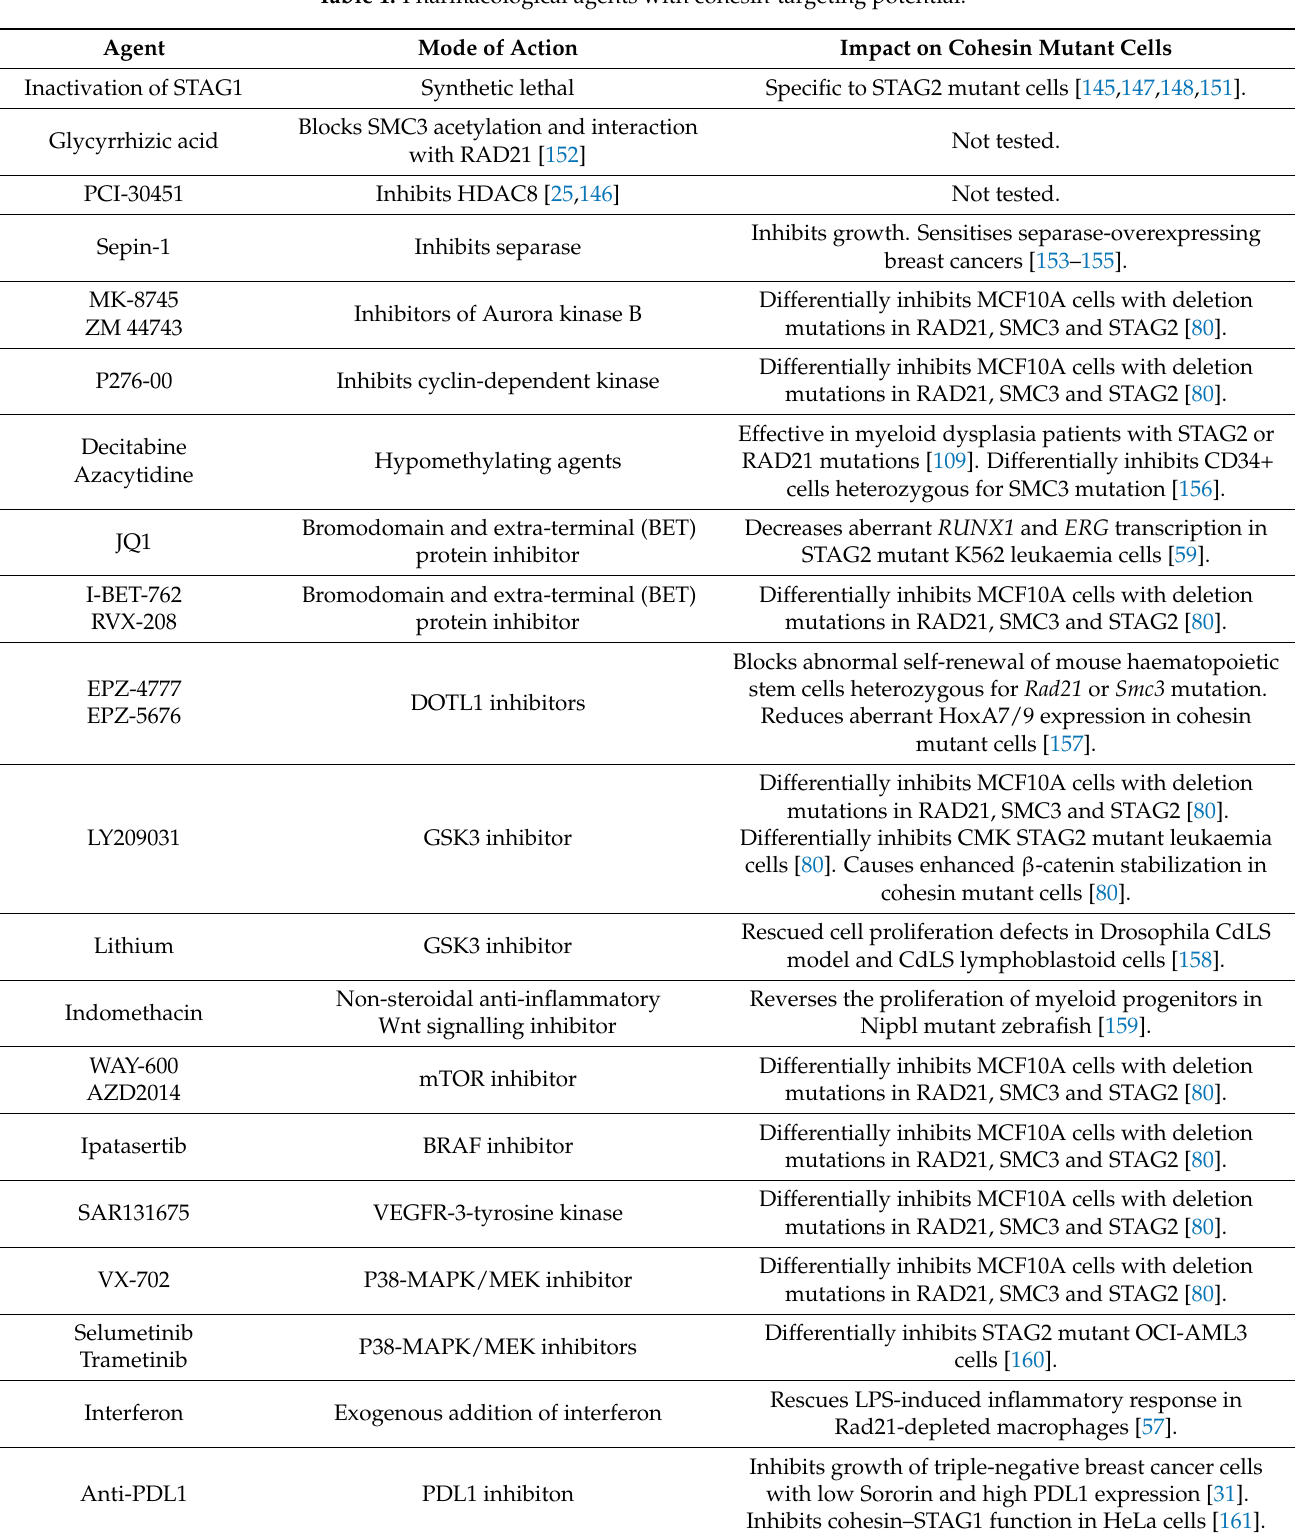
Table 1. Pharmacological agents with cohesin-targeting